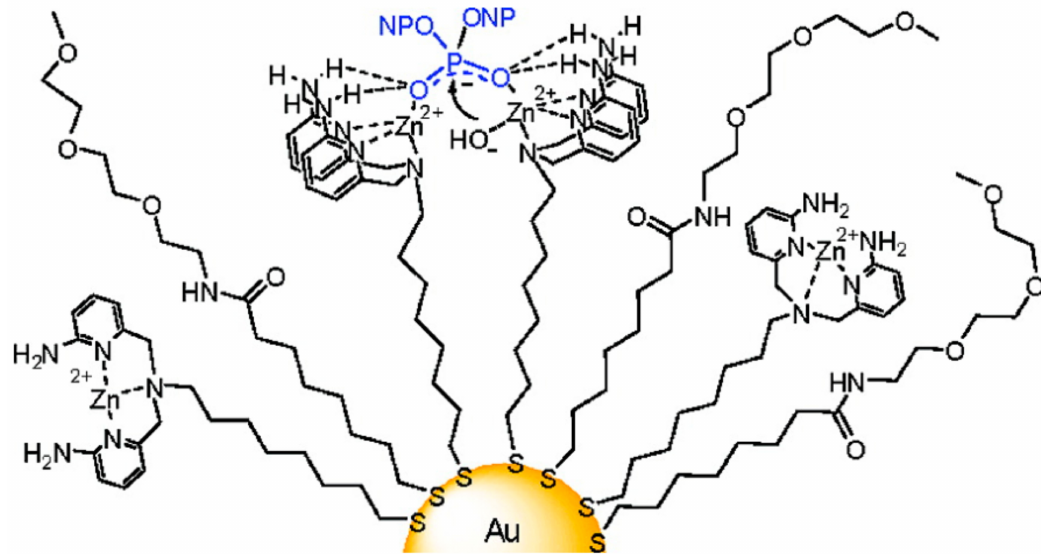
Figure 46. Bimetallic site bunching can build Zn(II) complexes attached to 2 nm diameter Au NPs. This site is demonstrated by the scission of a Bis-p-nitrophenyl phosphate DNA model substratum (BNP). Copyright 2008 ACS, reproduced with reference permission [326], Copyright 2008,